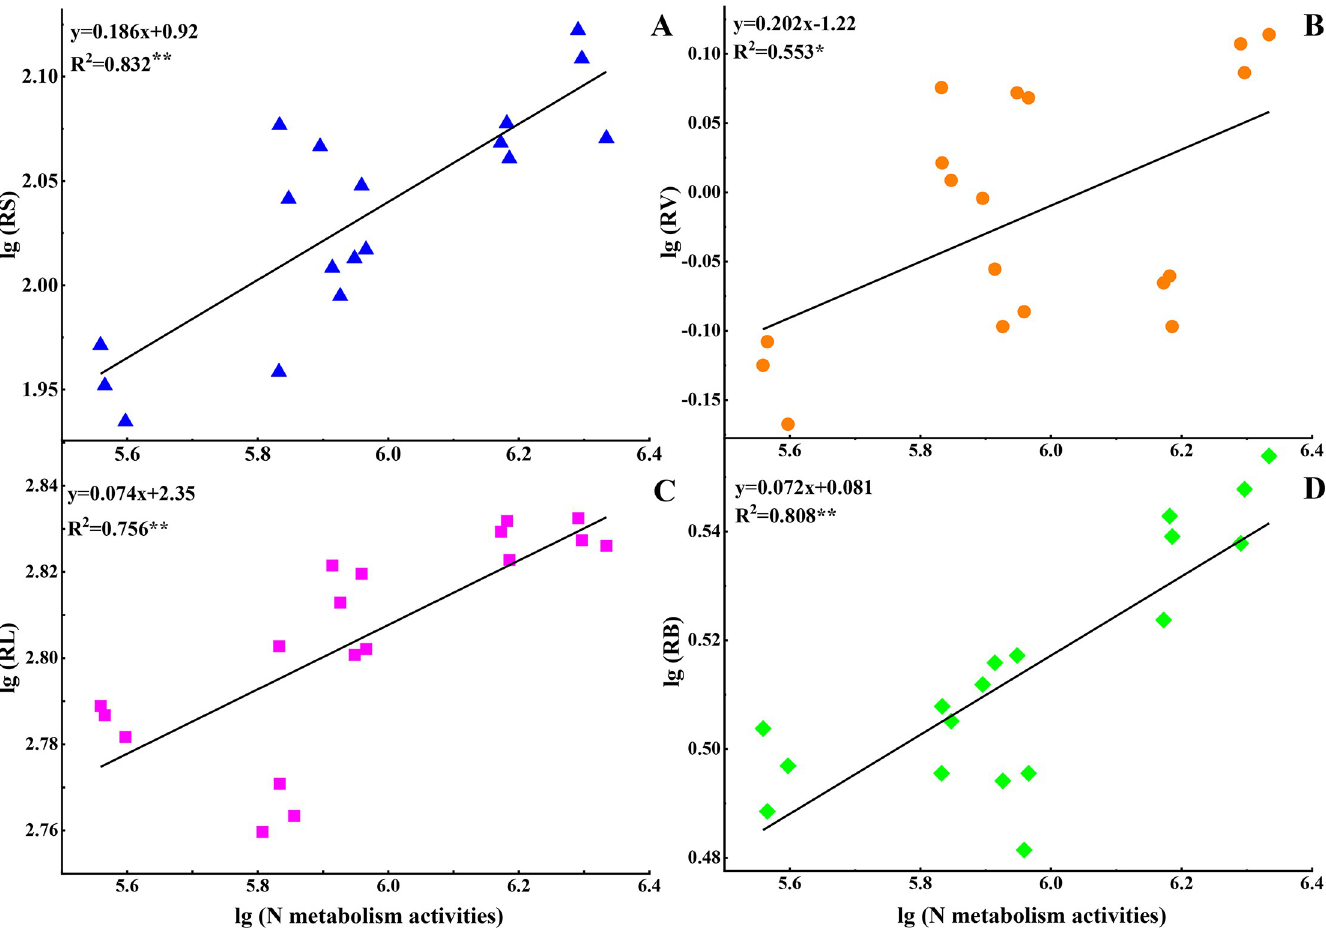
Fig 7. Correlations between root nitrogen metabolism and root morphology indices in soils with glucose addition and sterilization at day 45 �� . means P < 0.01, � means P <